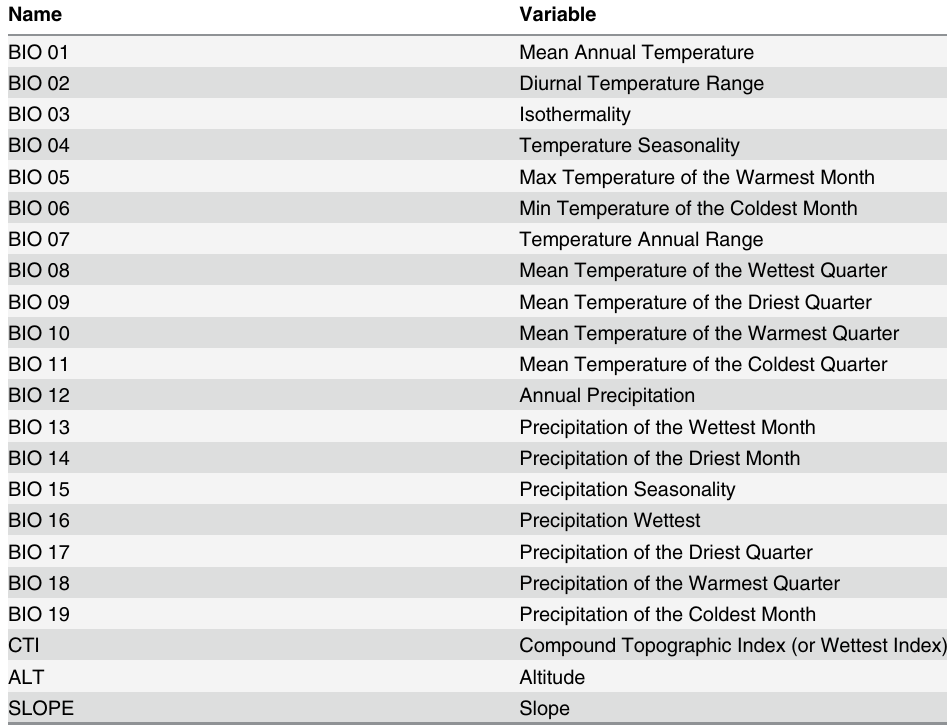
Table 1. Climate and topographic variables used for inferring the ecological niche and abundance models of the Bolson